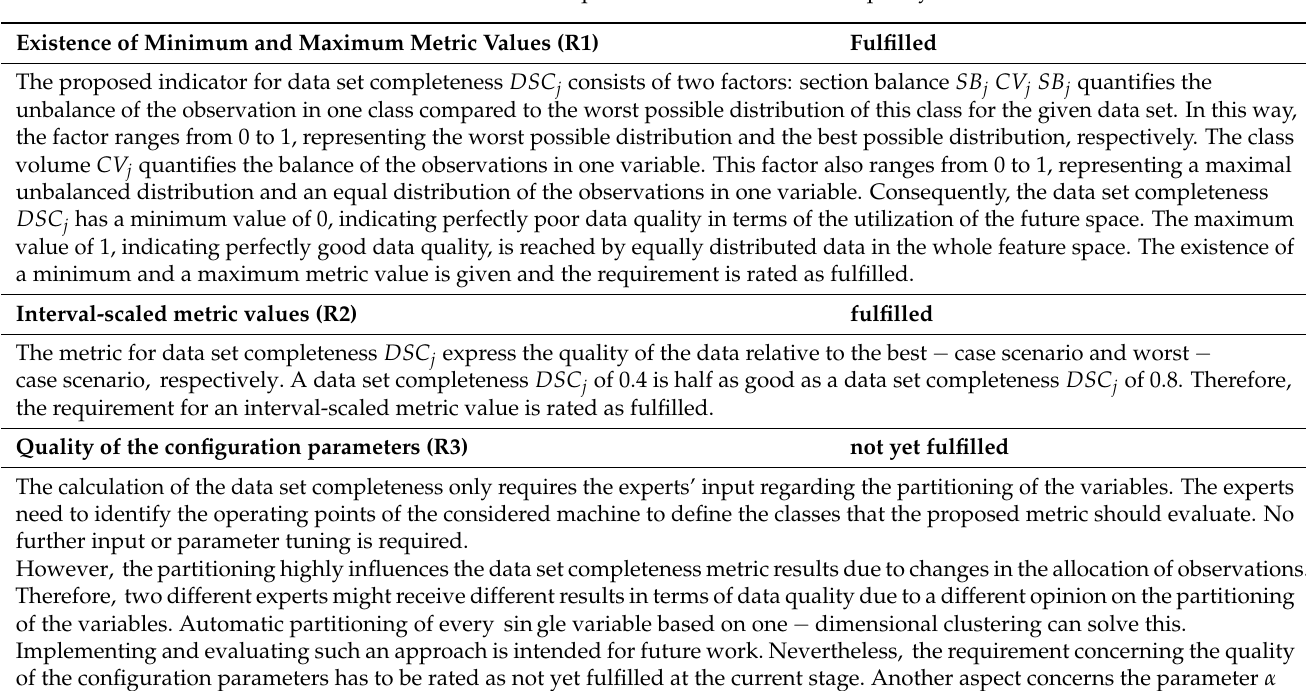
Table 4. Discussion of the requirements for efficient data quality